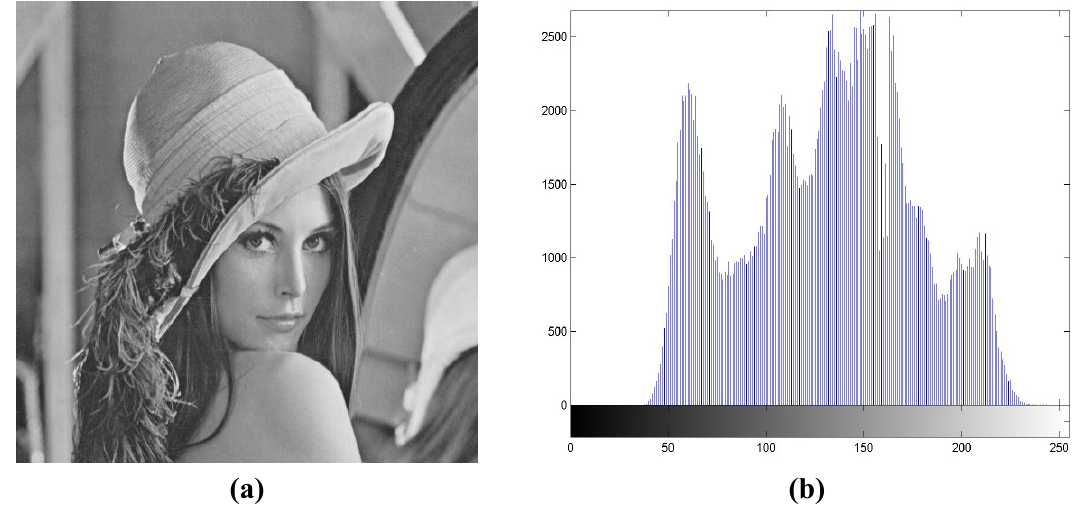
Figure 6. (a) The output image X'' in Figure 3(c), with PSNR = 51.13 dB. (b) Corresponding histogram with X'' . Correlation coefficient =